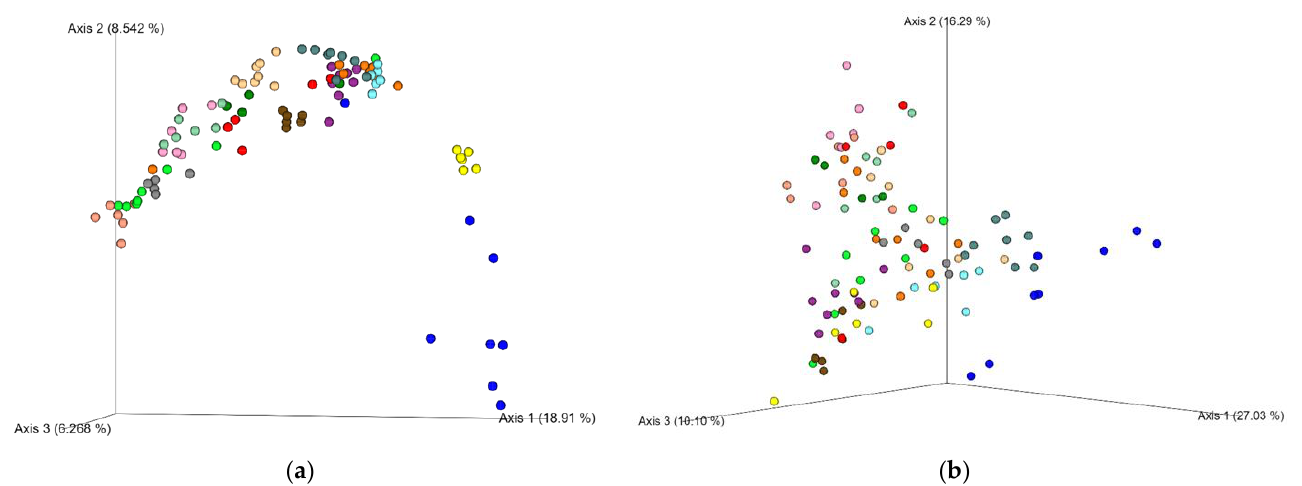
Figure 1. Unweighted ( a ) and weighted UniFrac ( b ) for all samples color-coded by the 15 different individuals.